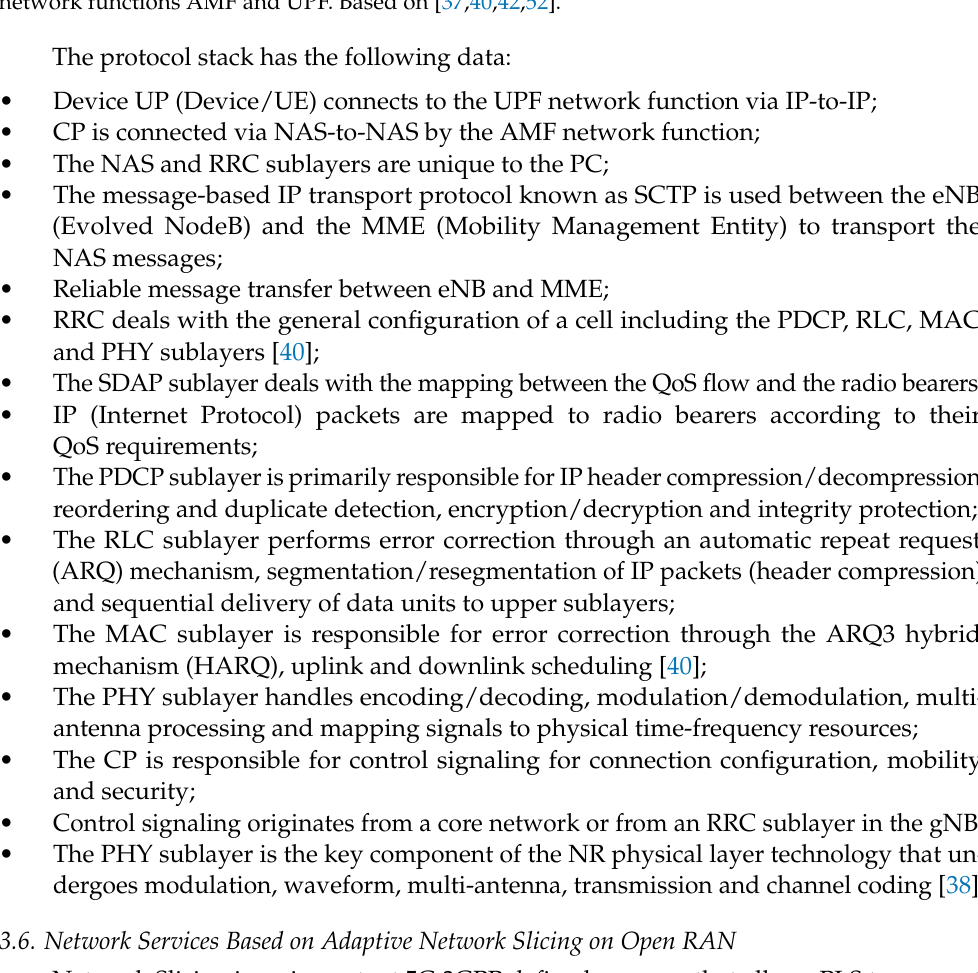
Figure 12. Access stratum for the user and control planes for UE/device and gNB protocol stack with network functions AMF and UPF. Based on